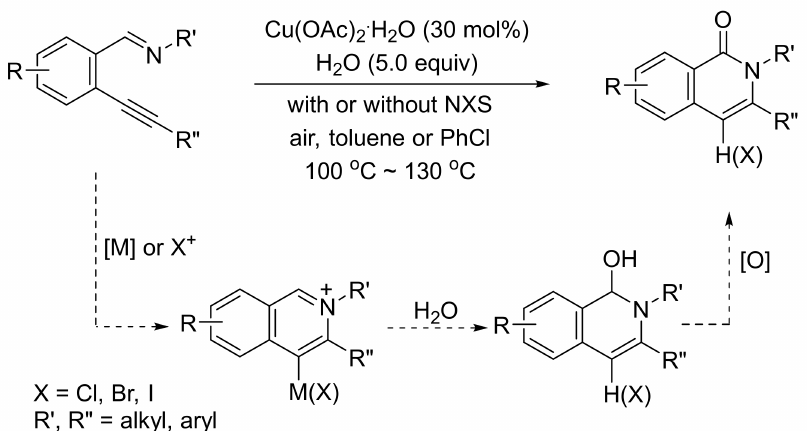
Scheme 30. Isoquinolone formation by copper(II)-catalyzed tandem reactions of 2-(1-alkynyl) benzaldimines with water. Moreover, 4-substituted isoquinolones can be prepared by a DBU-promoted isomer- palladium-catalyzed tandem Heck-Suzuki coupling reactions of ortho -iodo- N -(prop-2-